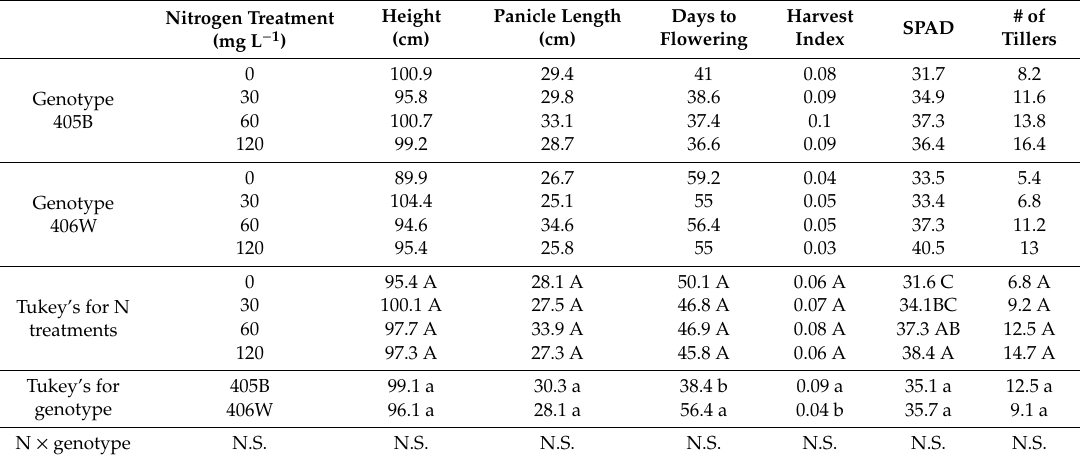
Figure 5. Shoot ( A ) and grain ( B ) dry matter in the summer field experiment by N fertigation level. Dashed line represents the 405B genotype, and solid line represents the 406W genotype. Di ff erent letters represent significant ( < 0.05) di ff erences for both main e ff ects. Letters adjacent to the trend line represent the results of the Tukey’s test for N concentration averaging both genotypes, and letters adjacent to the legend represent the results of the Student’s t -test for the two di ff erent genotypes. Table 3. E ff ect of N fertigation levels on growth parameters in the summer field experiment.